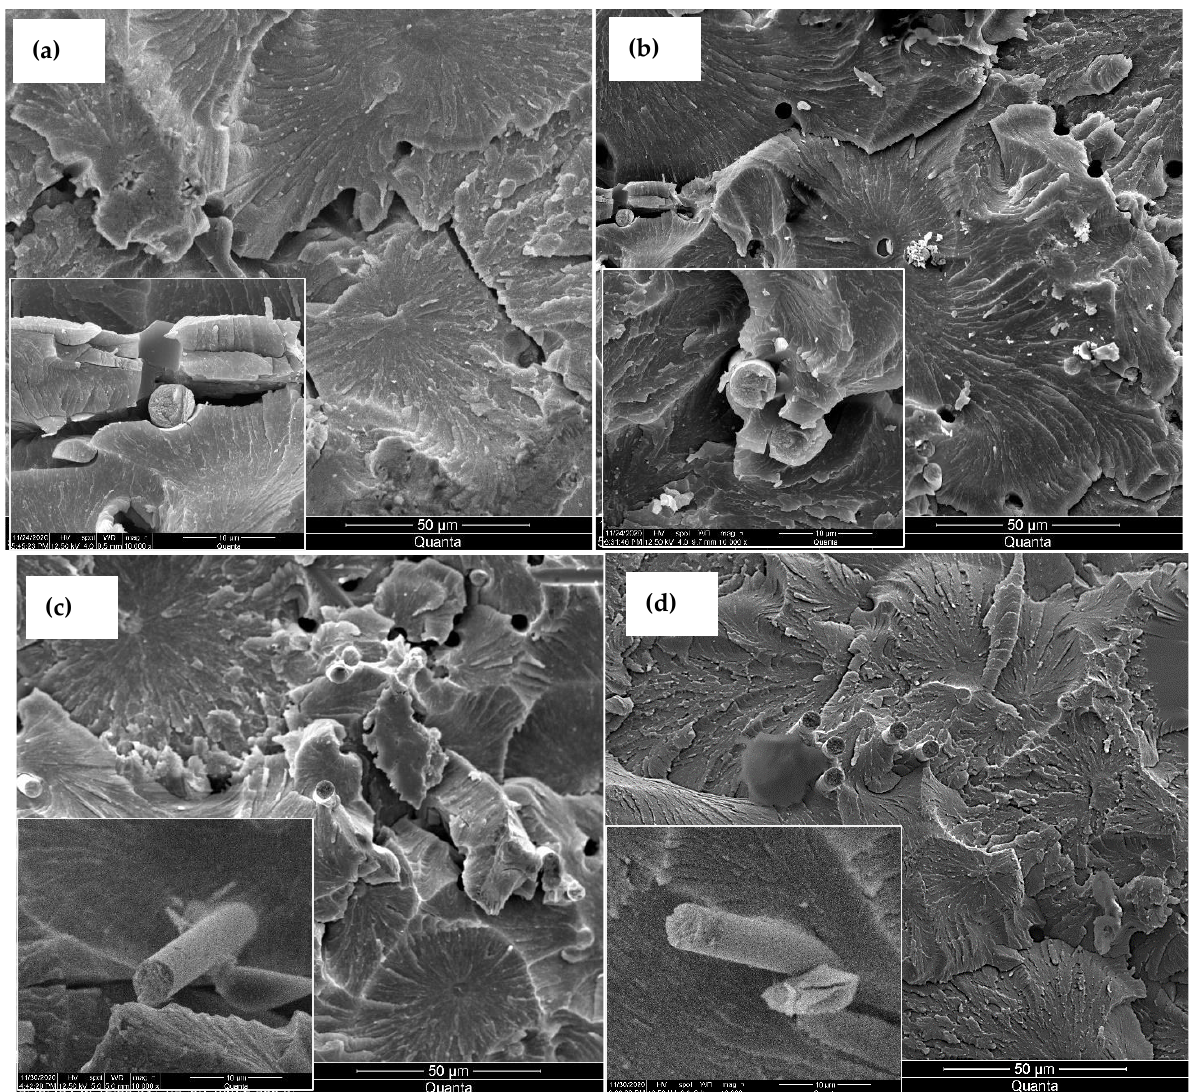
Figure 7. SEM fractography at different magnifications for composites based on ( a ) reference desized fibers, ( b ) acid-oxidized fibers, ( c ) fibers with surface-grown MOFs, and ( d ) fibers with CNTs. Inset images scalebar 10 µm.